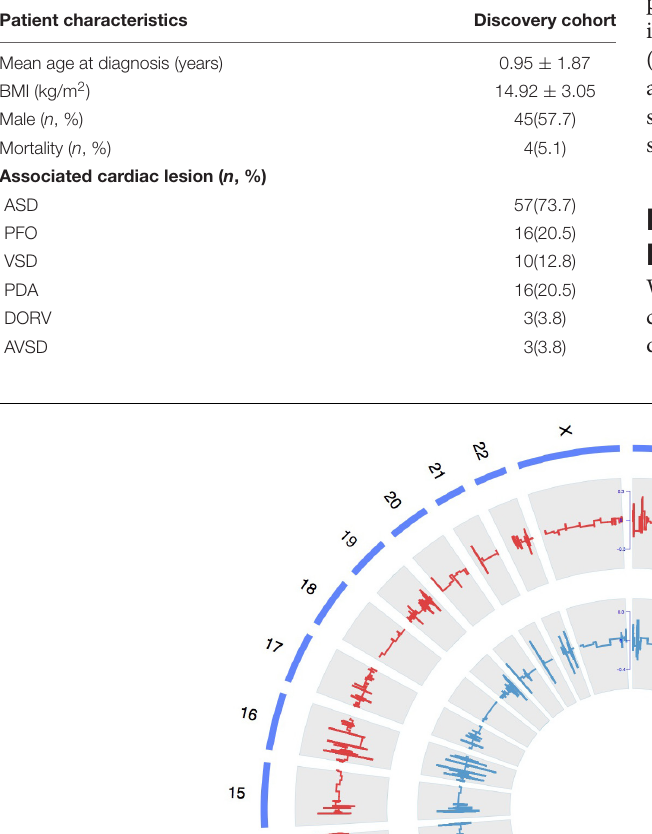
TABLE 1 | The summary of 78 TAPVC patients.